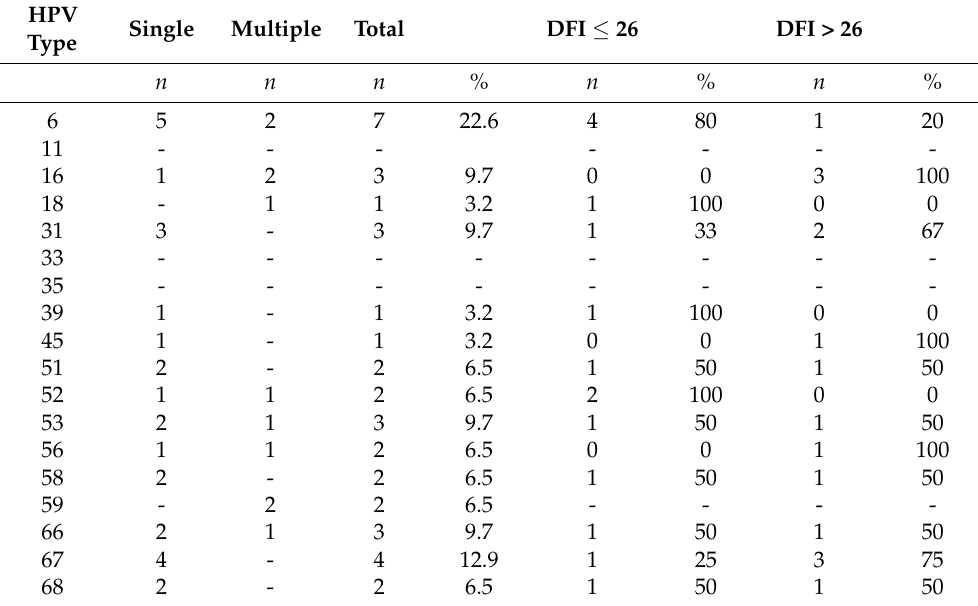
Table 2. Overview of the detected HPV types.